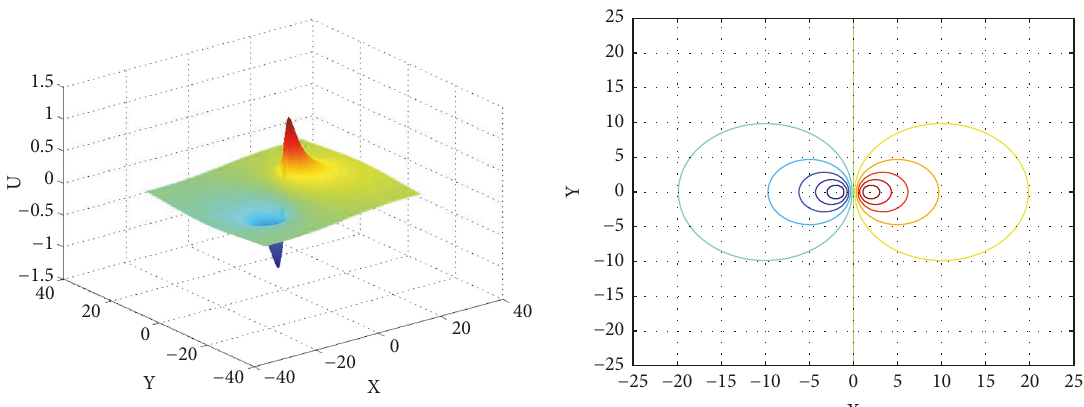
Figure 1: The 3D plot of lump (13) and the corresponding contour plot.